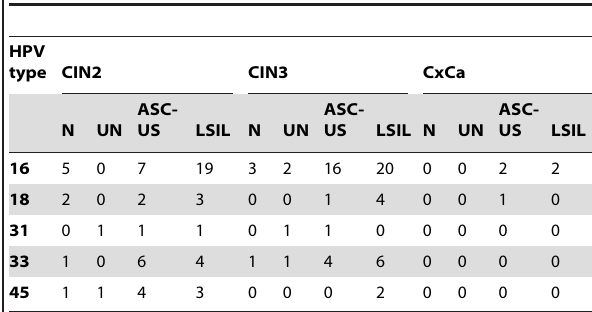
Table 4. Added value of the HPV test; number of HPV mRNA test positives having an underlying high-grade lesion not detected at triage